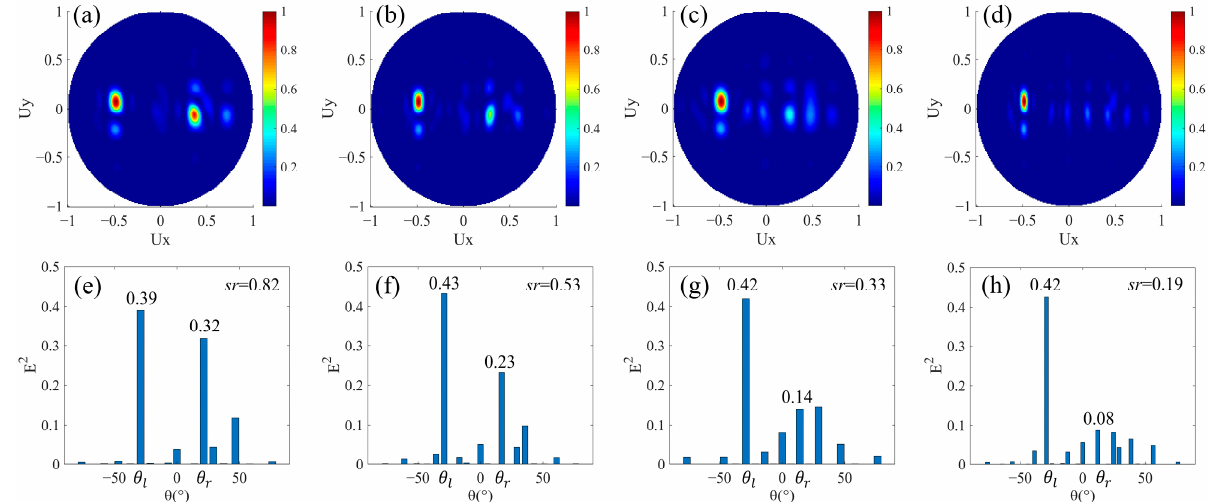
Figure 5. Simulation results of beam splitters with different split angles and energies. N l = N r , M ≠ 0. The normalized far-field projection intensity distributions of designs ( a ) N l = N r = 3, M = 1, ( b ) N l = N r = 3, M = 2, ( c ) N l = N r = 3, M = 3, and ( d ) N l = N r = 3, M = 4, respectively. ( e – h ) are the normalized field intensity under the main split angle corresponding to the results of ( a – d ), respectively.